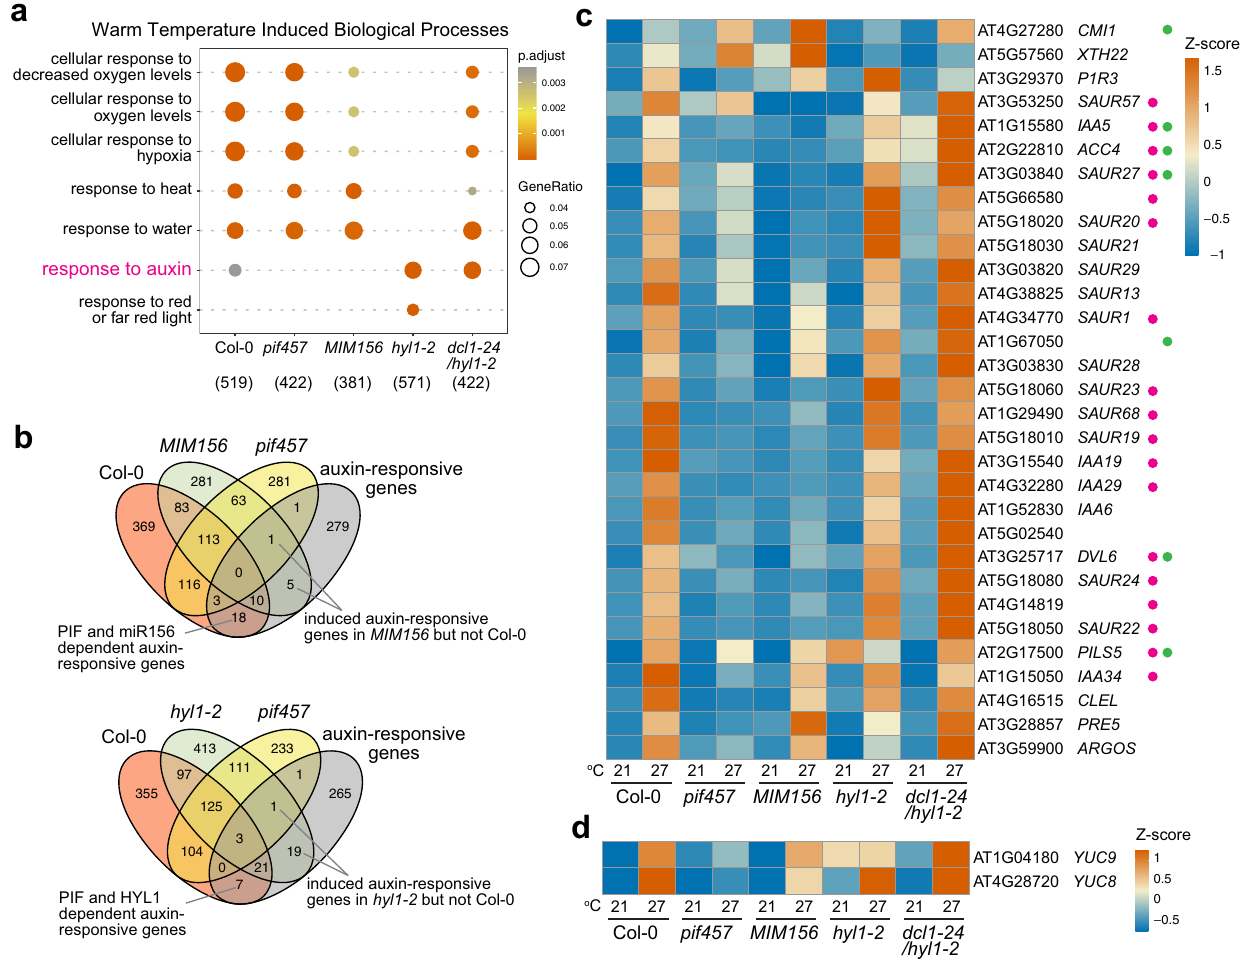
Fig. 4| MiR156 potentiatestheproperregulation ofauxin-responsivegenesby warm temperatures. a GO enrichment analysis of the top warm-temperature- induced biological processes in Col-0, pif457 , MIM156, hyl1-2 , and dcl1-24/hyl1-2 . A comparison of the enriched biological processes among the genetic backgrounds was performed using clusterPro fi ler 58 , with the strict cutoff of p <0.01 and FDR<0.05. The numbers in parentheses indicate the number of warm- temperature-induced genes in each genotype. b Venn diagrams showing the numbers of warm-temperature-induced auxin-responsive genes (GO:0009733) in